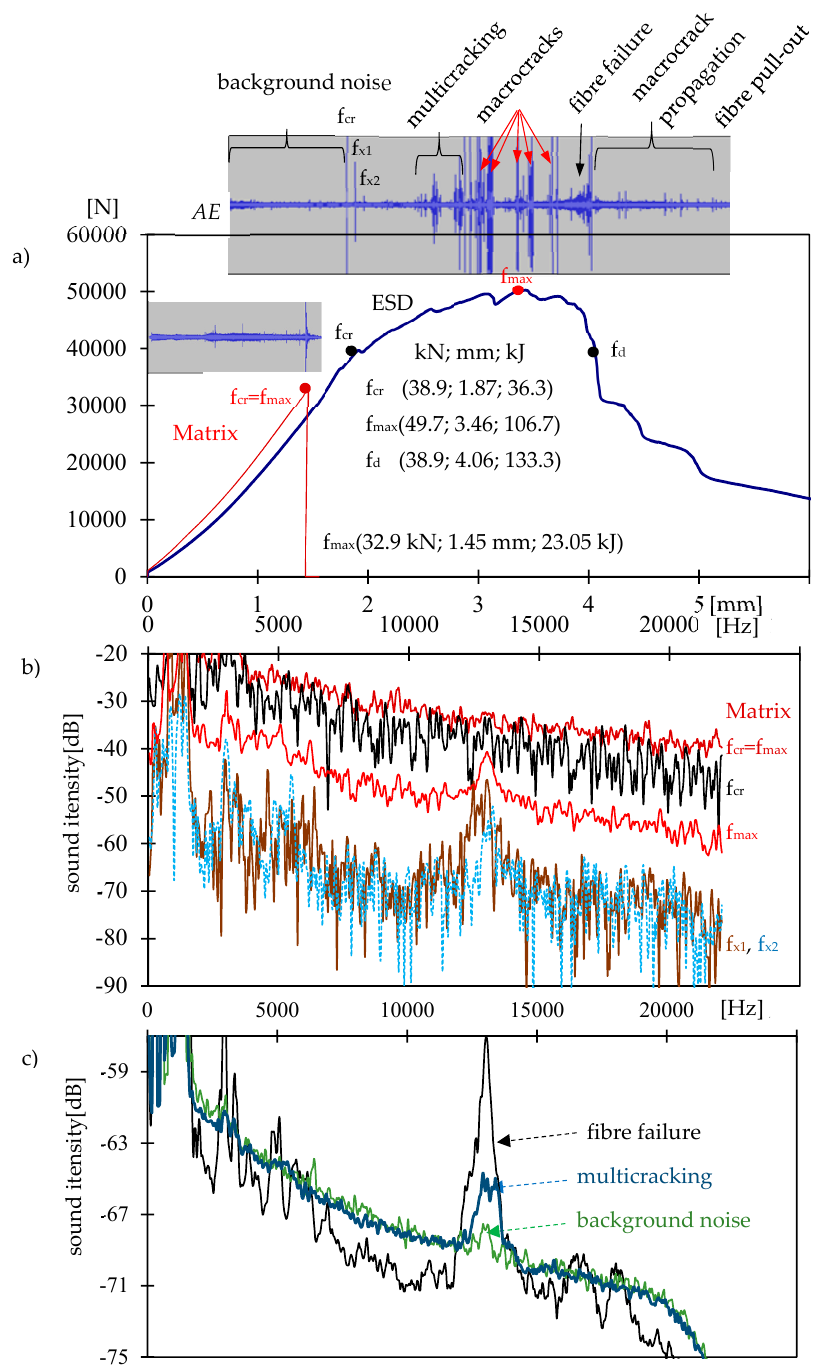
Figure 4. Matrix and ESD composite: ( a ) load-deflection curve, ( b ) 2D spectra of the matrix and ESD composite, ( c ) 2D spectrum of the ESD composite.